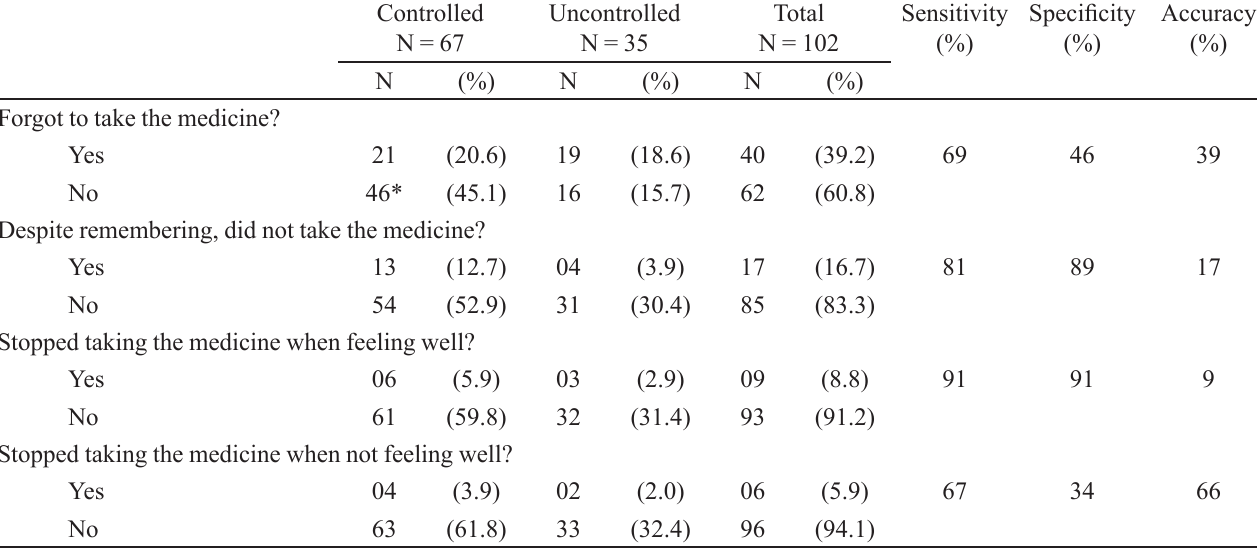
TABLE II - Distribution of controlled and uncontrolled hypertensives according to the Morisky-Green test